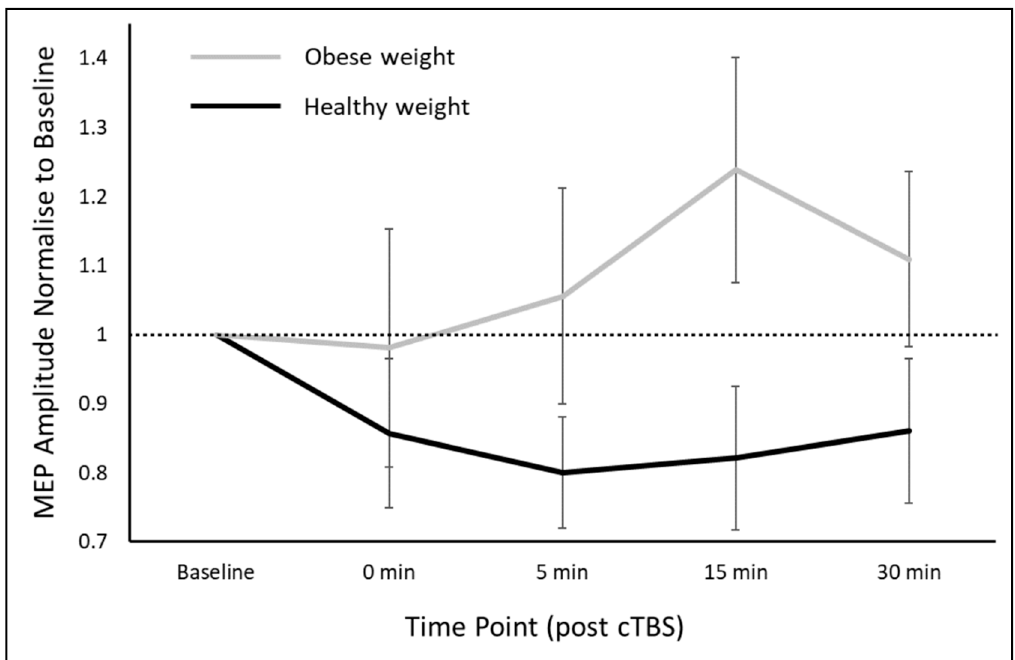
Figure 1. Comparison of the cTBS response between healthy-weight adults and people who are obese. There was a GROUP effect with healthy-weight participants demonstrating the expected suppression of MEP amplitudes following cTBS. Data are expressed as group mean ± SD. cTBS, continuous theta burst stimulation; MEP, motor evoked potential.